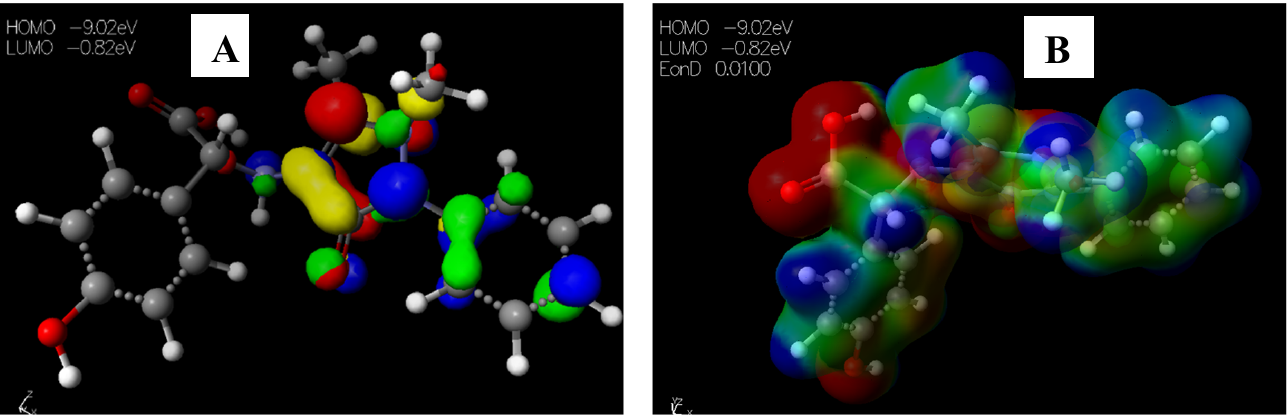
Figure 9. Images showing the ( A ) Highest occupied molecular orbital (HOMO) and Lowest unoc- cupied molecular orbital (LUMO) and ( B ) Molecular electrostatic potential (MESP) plots of 5.